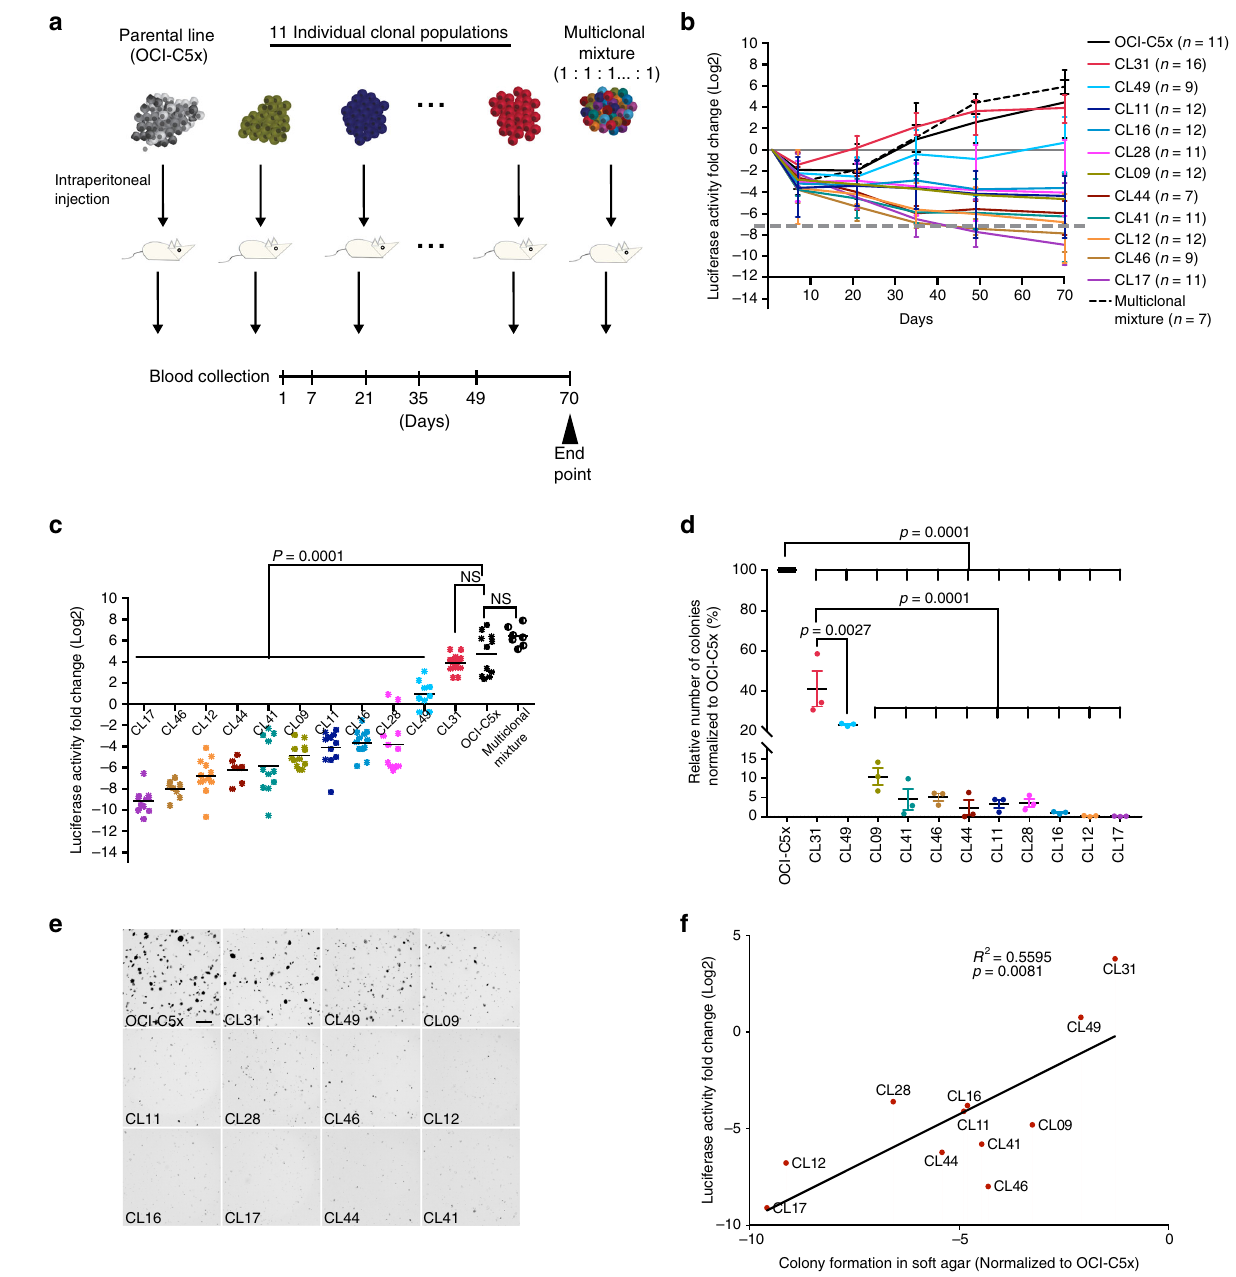
Fig. 1 Clonal populations display variable growth dynamics in vivo. a Schematic depiction of tumor cell populations inoculated into immunocompromised (NSG) female mice. b Tumor growth dynamics in vivo assessed by measurement of luciferase activity in whole blood samples collected at the indicated time points. Dashed line represents Gluc values at background levels. Data presented as fold change in luciferase activity compared to 24 h post injection. Data represent mean ± SD of each group ( n = as indicated) from three independent experiments. c Fold change in luciferase activity per mouse determined as in ( b ) at the 10-week end point. p Values were computed using the one-way ANOVA test followed by Dunnett ’ s multiple comparison test, comparing parental line to each of the clones and the multiclonal mixture. NS not signi fi cant. d Colony formation in soft agar measured after 21 days and normalized to the parental line. Data represent mean ± SEM from three independent experiments, biological replicates were performed on cells that had been passaged anywhere between 8 and 23 times. p Values were computed using the one-way ANOVA test followed by Dunnett ’ s multiple comparison test, comparing either parental or CL31 against each of the clones. e Images of a representative soft agar colony formation assay from one of three independent experiments. Scale bar represents 1 mm. f Linear regression analysis of colony formation in soft agar and tumor burden (measured by luciferase activity in blood samples collected at 10-week end point) for all 11 clonal populations. p = 0.0081, two-tailed. See also Supplementary Figs. 1 –